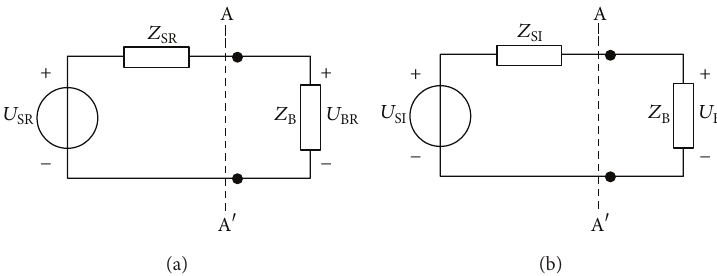
Figure 2: The equivalent circuit model for analyzing the equipment B response. (a) Radiation test. (b) Injection test.